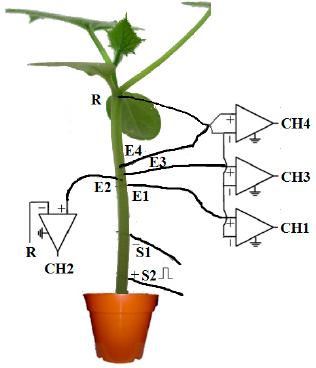
Figure 5. Extracellular recording sketch. S1 and S2 are stimulating electrodes; S1 is the anode. E1, E2, E3, and E4 are measuring electrodes; R represents reference electrode and is placed in the node of stem, with respect to the ground. The distance between S2 and E1 is 2 cm, and there is 0.2–0.3 cm between adjacent measuring electrodes.